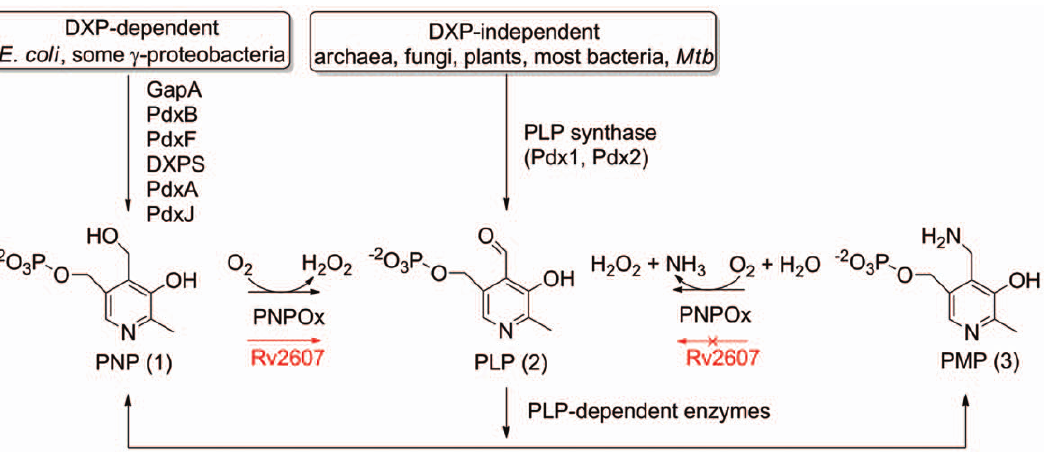
Figure 1. PLP formation catalyzed by PNPOx and associated vitamin B6 metabolic pathways. The role of Rv2607 is shown in red. In E. coli , PNPOx catalyzes the last step in the DXP-dependent PLP biosynthetic pathway [2]. Most organisms capable of PLP biosynthesis produce PLP via PLP synthase, a macromolecular complex consisting of Pdx1 and Pdx2 [2]. Organisms with genes that encode both PLP synthase and PNPOx likely use PNPOx to salavage PLP from PNP and PMP, which are produced by enzymes that use PLP as a cofactor.